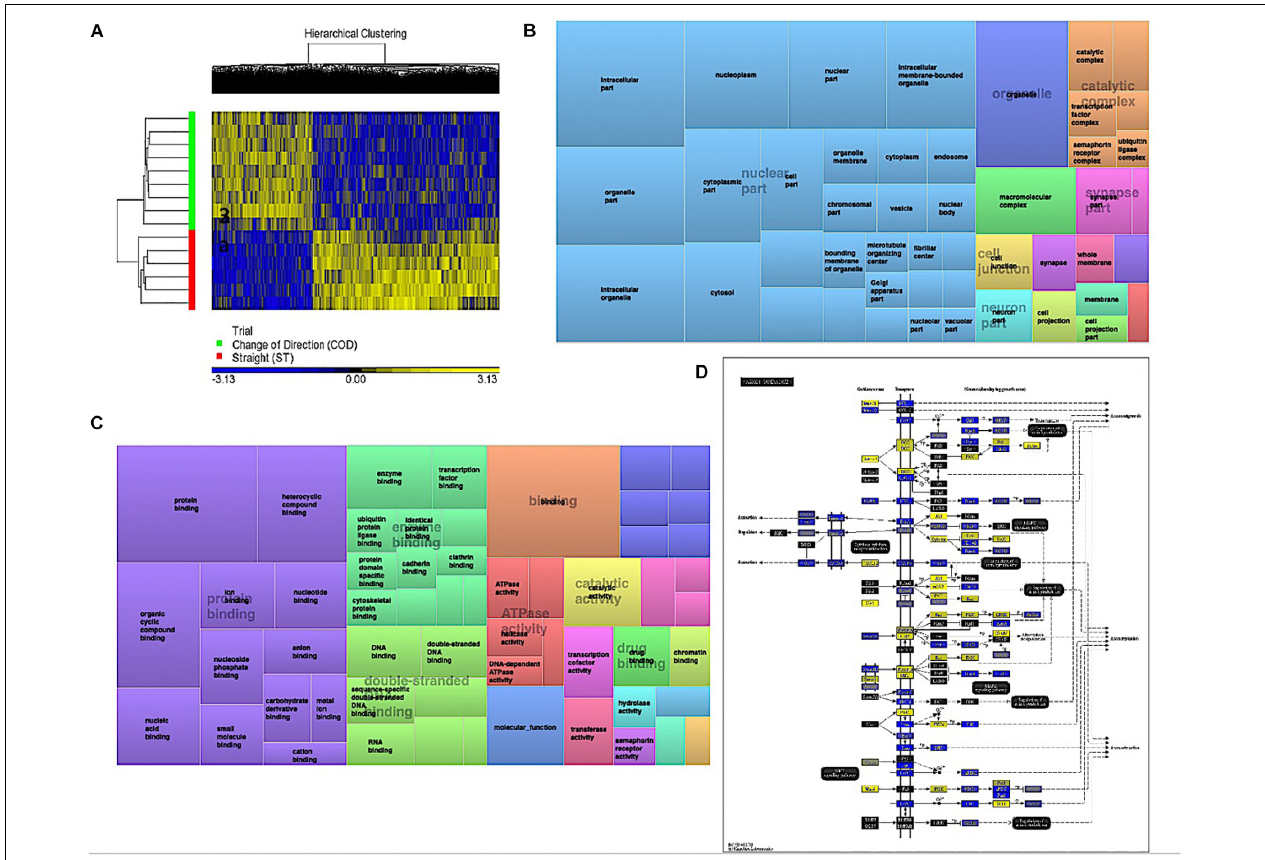
FIGURE 2 | (A) Hierarchical heat map for analysis of DMPs in COD vs. ST trials across all time. (B) DMP enrichment TreeMap of overarching Gene Ontologies (GO) term ‘cellular component’ in COD vs. ST trials. Demonstrating top enriched GO terms of ‘intracellular part,’ ‘organelle,’ and ‘intracellular organelle part.’ (C) DMP enrichment TreeMap of overarching GO ‘molecular function.’ Demonstrating top enriched GO terms of ‘protein binding’ and ‘binding.’ (D) Illustration of the top KEGG pathway ‘axon guidance’ demonstrating predominantly hypomethylation (blue) in COD vs. ST sprint trials. Note, the most significant (lowest p -value) DMP